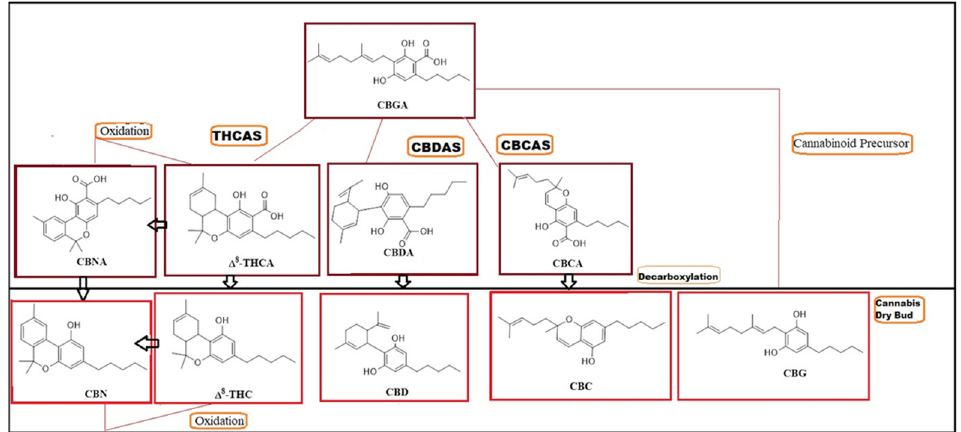
Figure 1. Structures of major components in the medicinal Cannabis . cannabigerolic acid, CBGA; tetrahydrocannabinolic acid synthase, THCAS; cannabidiolic acid synthase, CBDAS; cannabichromene acid synthase, CBCAS; tetrahydrocannabinolic acid, THCA; cannabidiolic acid, CBDA; cannabichromenic acid, CBCA; cannabinolic acid, CBNA; cannabichromene, CBC; cannabidiol, CBD; cannabigerol, CBG; cannabinol, CBN; and tetrahydrocannabinol, THC.